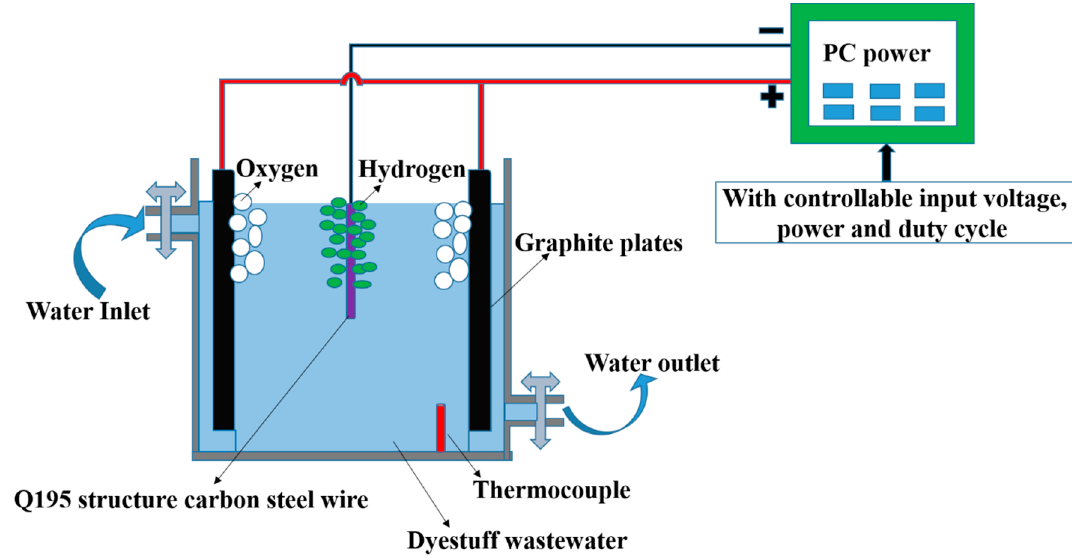
Figure 1. Experimental power source and electrode device.